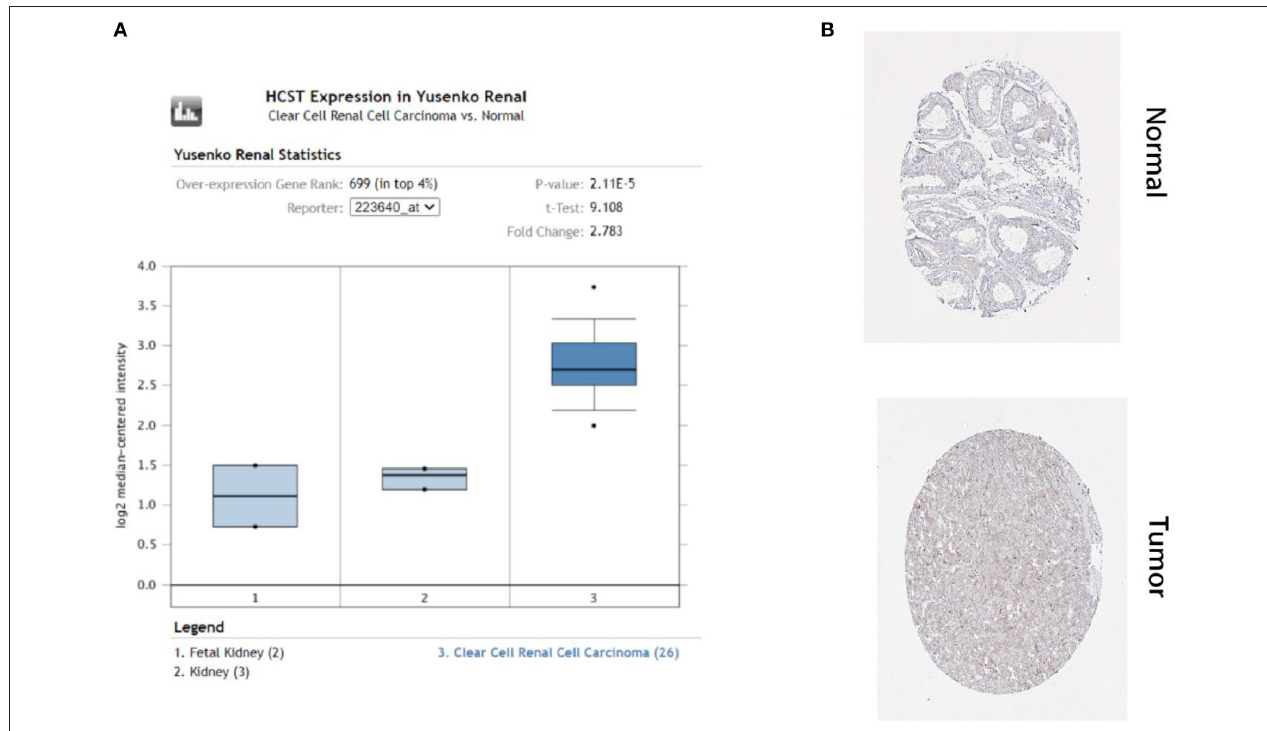
FIGURE 4 | HCST protein expression was significantly higher in ccRCC tissues than normal tissues. Representative IHC images of HCST (A) in normal (left) and ccRCC (right) tissues. Images were downloaded from the HPA database. Statistical analyses of the protein expression levels of the HCST according to the information of normal and ccRCC tissues (B) from